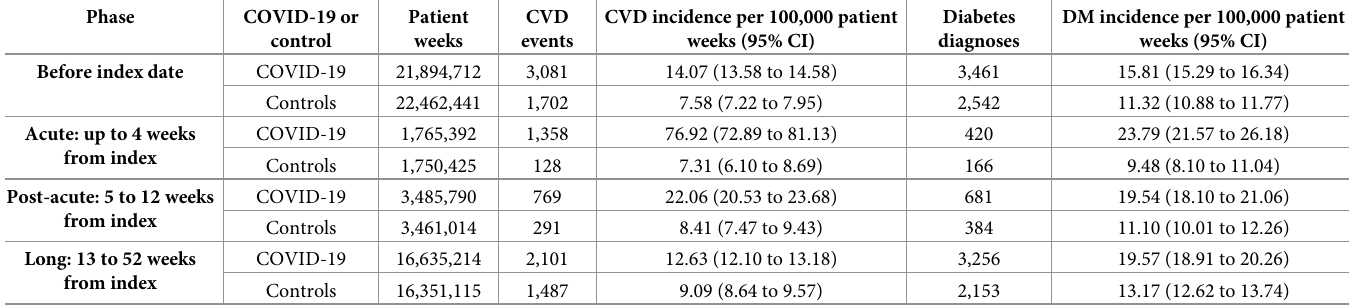
Table 2. DM and CVD events and rates by period for COVID-19 cases and controls. Figures are frequencies except where indicated.